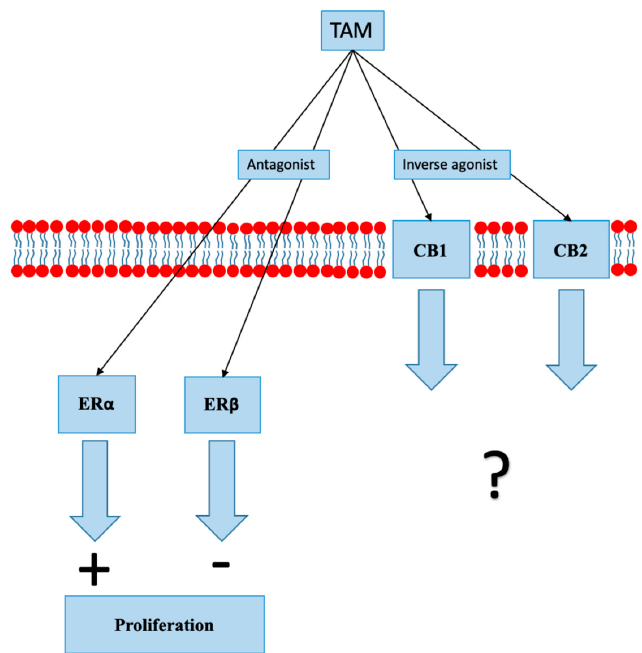
Figure 3. In addition to its action on estrogen receptors (ER), tamoxifen (TAM) acts as an inverse agonist at cannabinoid receptors 1 and 2 (CB1 and CB2). The clinical significance of inverse agonist action on cannabinoid receptors is unknown.